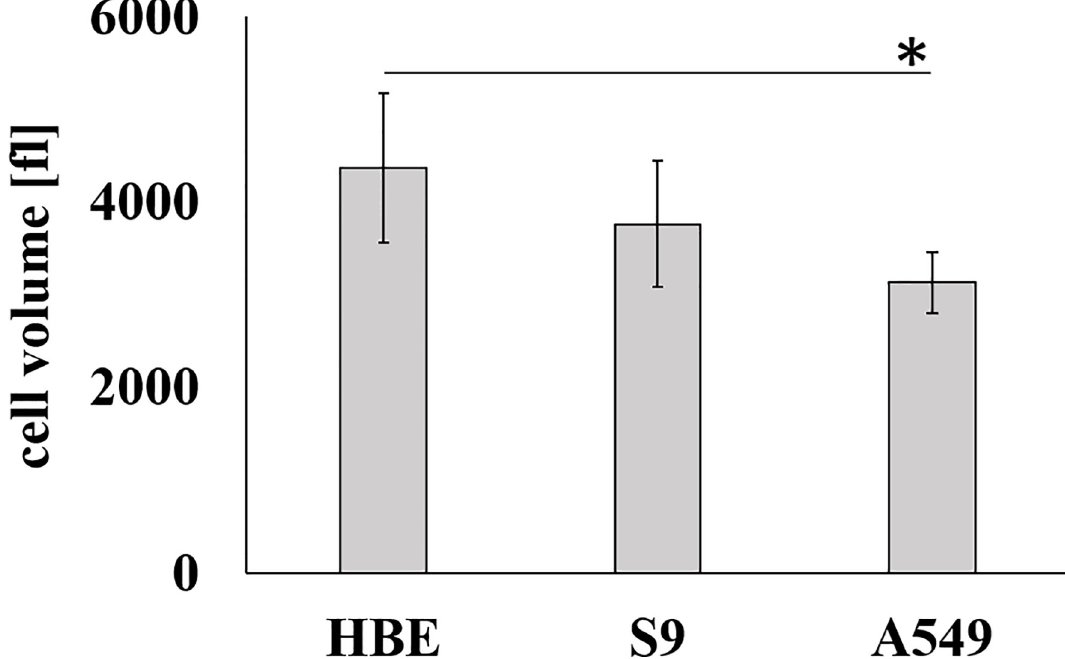
Fig 3. Mean cell volumes of 16HBE14o-, S9 and A549 cells in suspension. Individual means were tested for significant differences using Student’s t-test: � = p � 0.05 (means ± S.D.; n = 4).